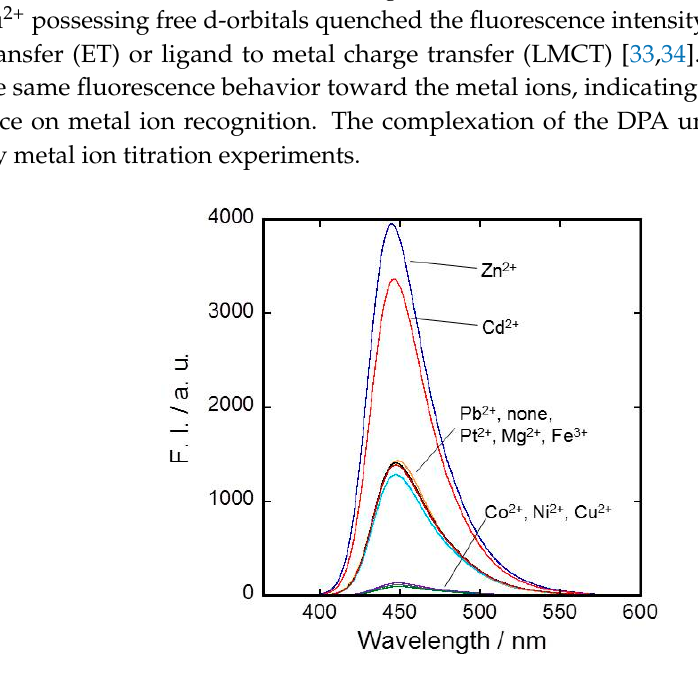
Figure 2. Fluorescence spectra of 1 β in the presence of metal ions in water, pH 6.4 adjusted by piperazine-1,4-bis(2-ethanesulfonic acid) (PIPES)/NaOH buffer, at 25 °C ( λ ex = 369 nm). [ 1 β ] = 0.010 mM, [(Metal)(NO 3 ) n ] or [K 2 PtCl 4 ] = 0.010 mM, [NaNO 3 ] = 0.10 M (M = mol dm − 3 ).